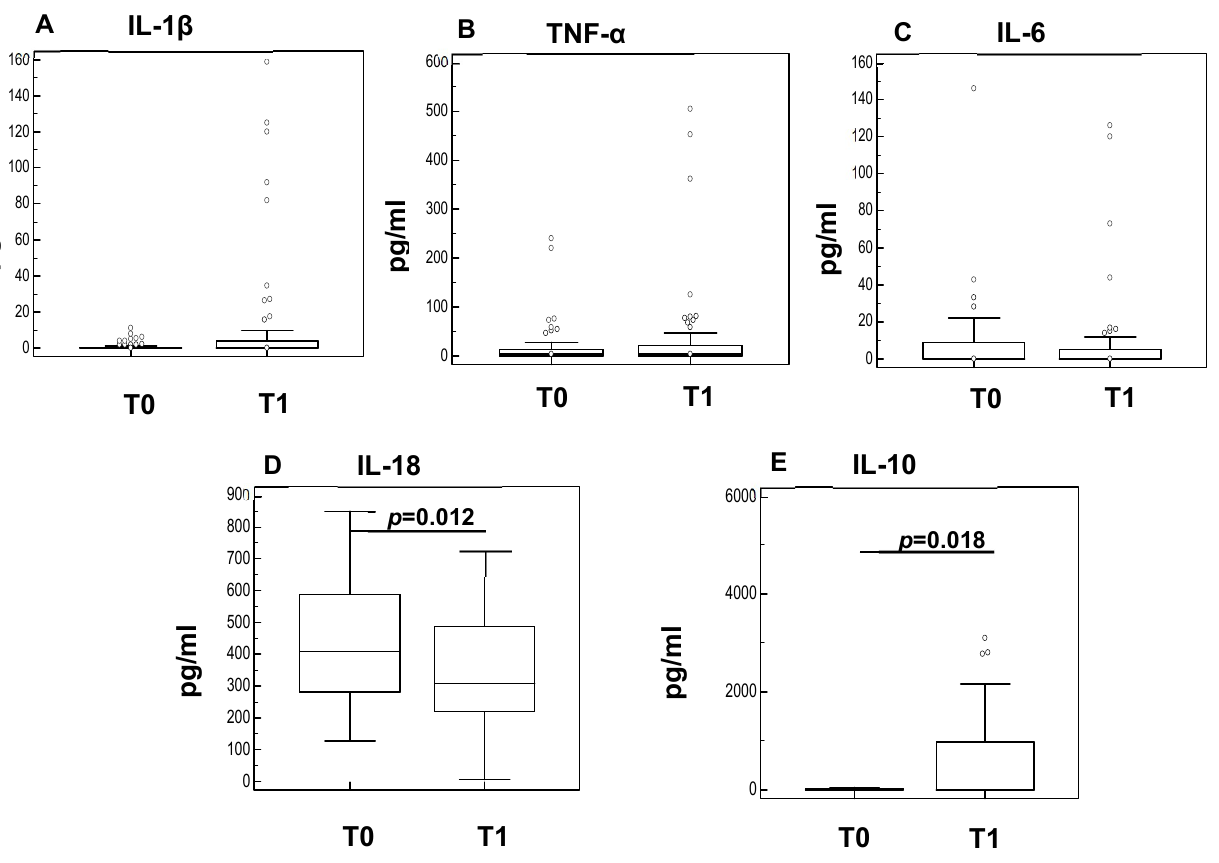
Figure 2. Plasmatic interleukin-(IL)-1β ( A ), TNF-α ( B ), IL-6 ( C ), IL-18 ( D ), and IL-10 ( E ) level at baseline (T0) and one month later at the conclusion of the rehabilitation protocol (T1). The boxes indicate the median and the first and third quartiles. Outliers are presented as dots; statistical significance (Mann–Whitney test) is indicated.